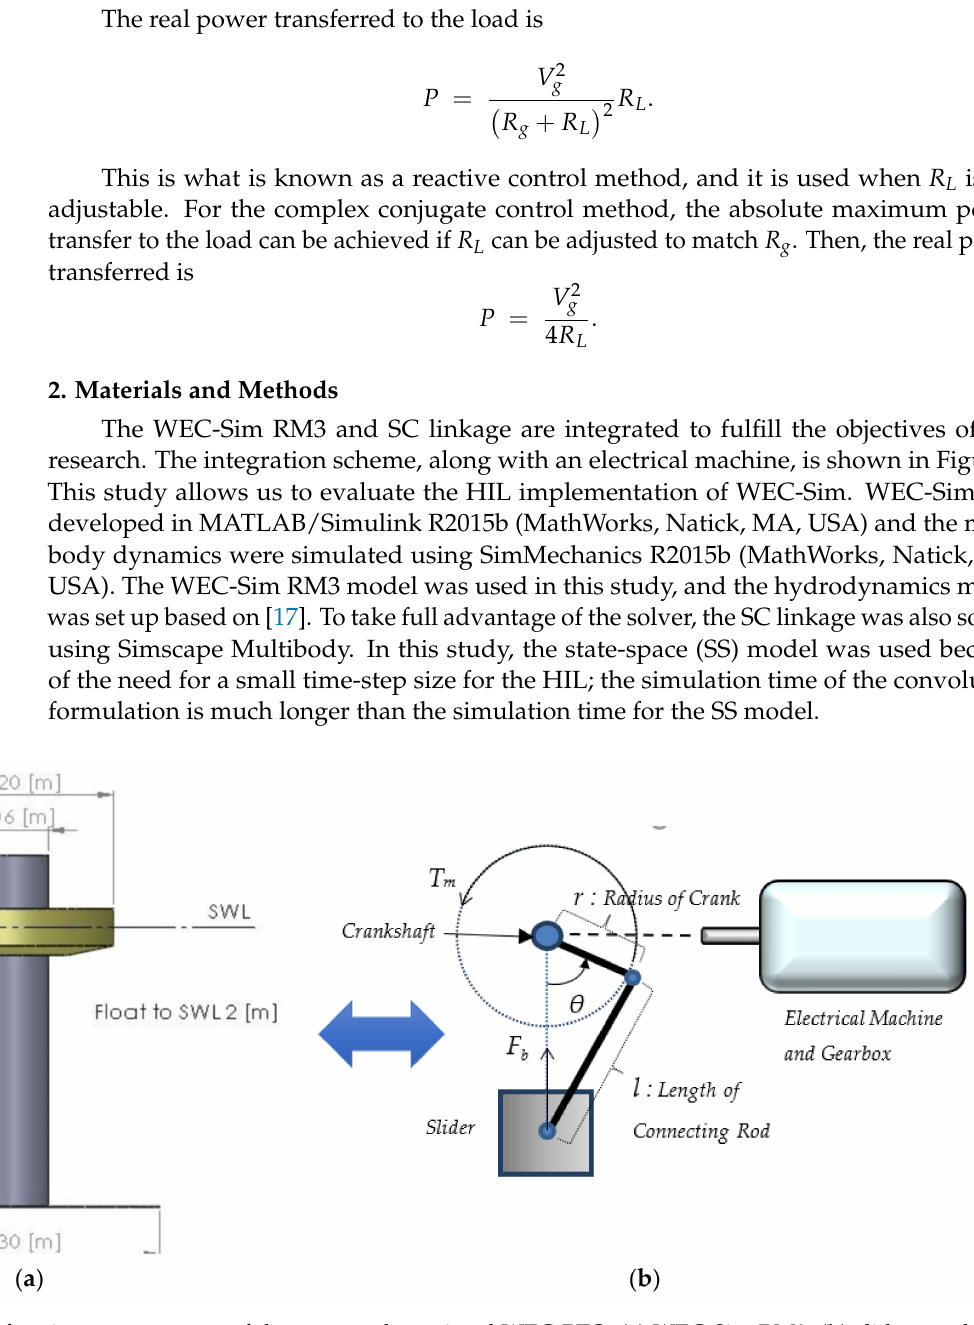
Figure 2. Integration of various components of the proposed rotational WEC-PTO. ( a ) WEC-Sim RM3, ( b ) slider-crank linkage model describing system variables ( T m , F b , r , l , θ ), radial flux electrical machine, and